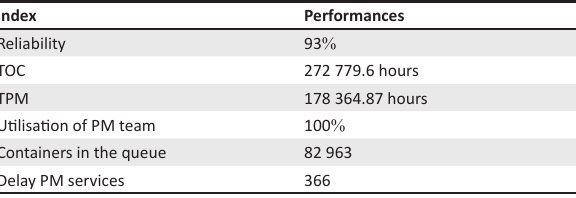
TABLE 9: Shorter shifts for preventative maintenance technicians.